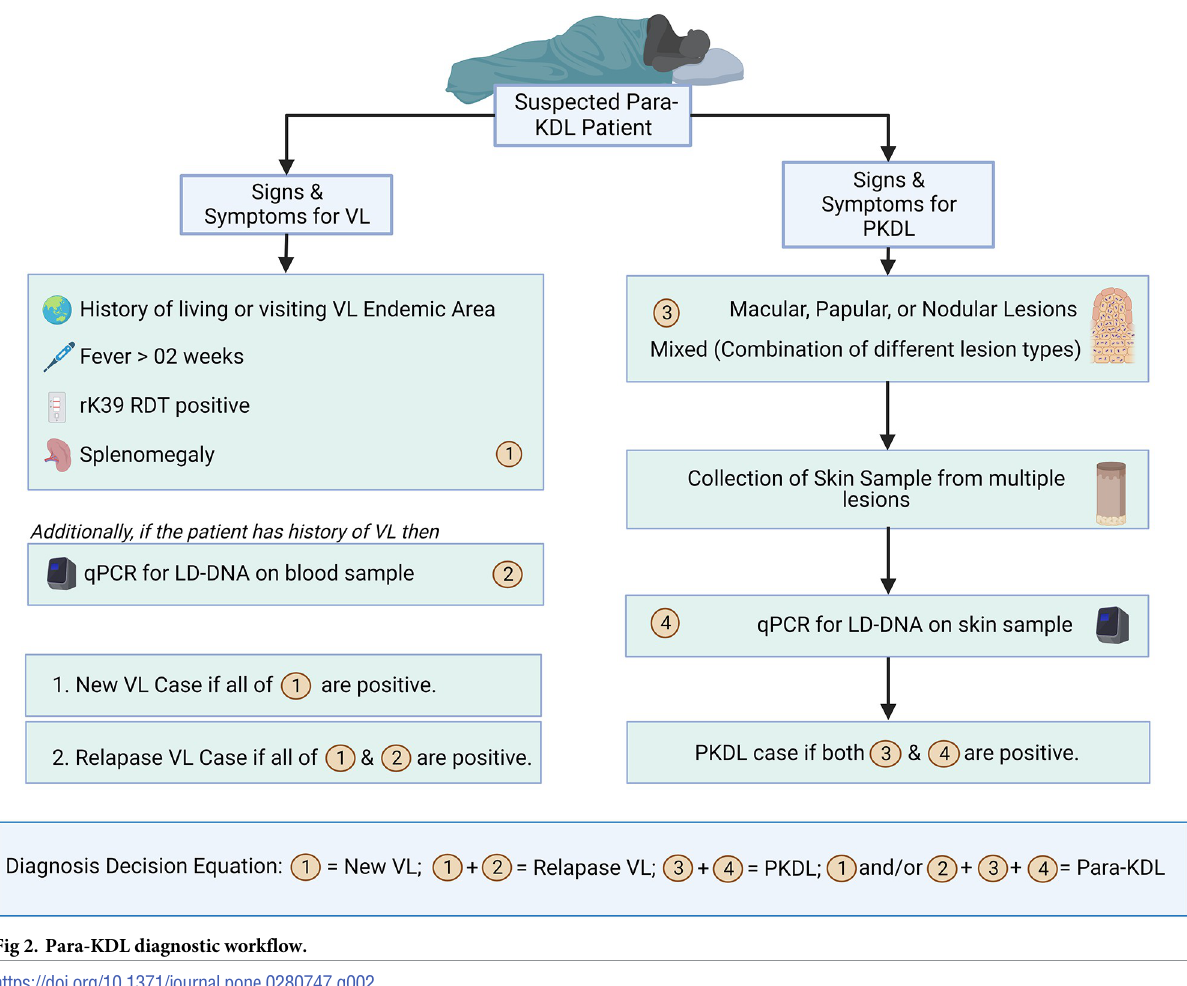
Fig 2. Para-KDL diagnostic